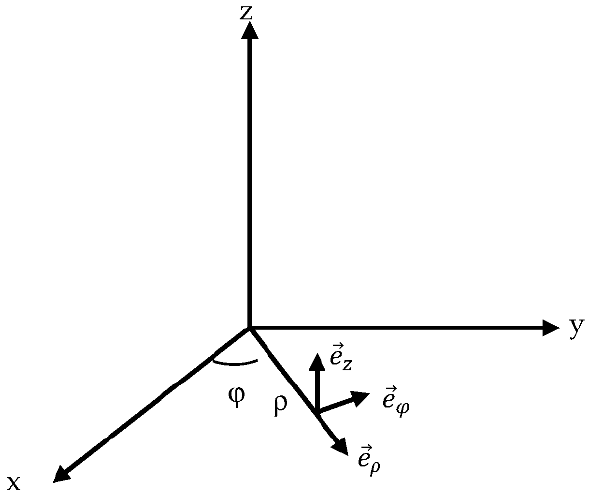
Figure 3. Reference frame and unit vectors for cylindrical coordinates.